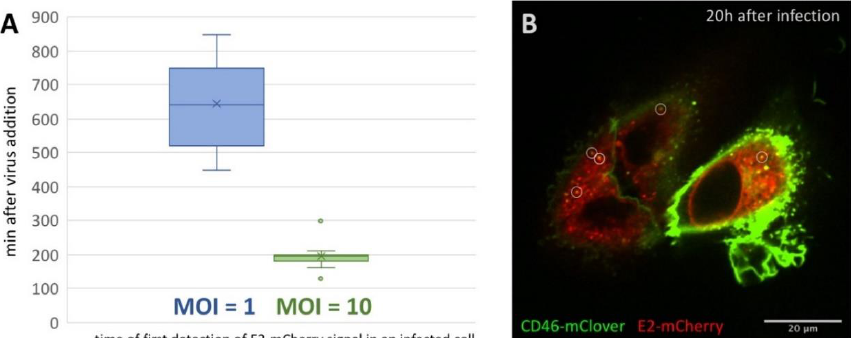
Figure 2. E2-mCherry signal development but not signal distribution is depending on the MOI. ( A ) Occurrence of E2-mCherry signal in min after addition of BVDV E2-mCherry at an MOI of 1 (blue) or 10 (green) to SK6 CD46 fluo cells. SK6 CD46 fluo cells were imaged recording one frame every 10 min at one z-level for 16 h. The mean is indicated by x and outliers (Q3 + 1.5-times interquartile range) are indicated by dots. ( B ) Distribution of E2-mCherry (red) and CD46 fluo (green) signal 20 h after infection with BVDV E2-mCherry in SK6 CD46 fluo cells. SK6 CD46 fluo cells were imaged for 10 min recording 3 z-levels (0.8 µ m) every 10 s (movie 6). Points of high E2-mCherry intensity that are colocalizing with CD46 fluo are indicated by white circles.